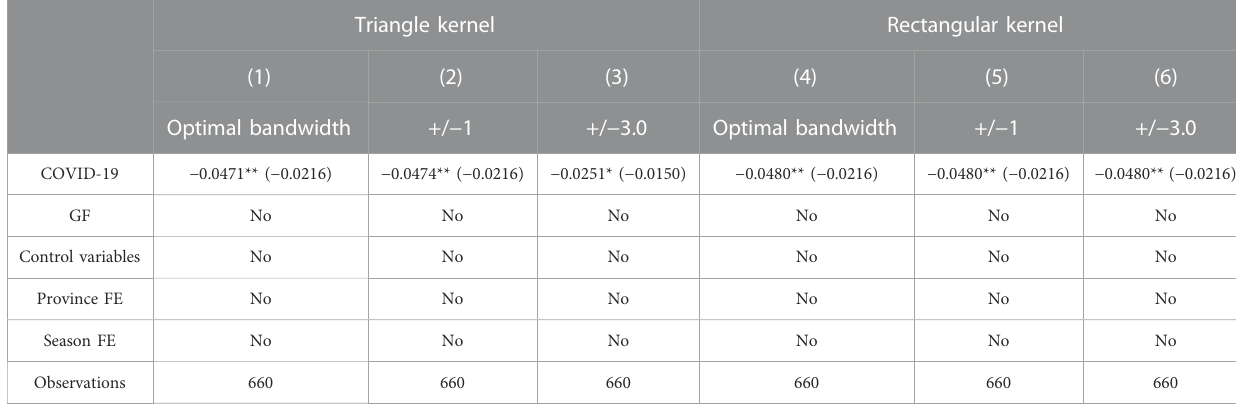
TABLE 3 Benchmark regression results